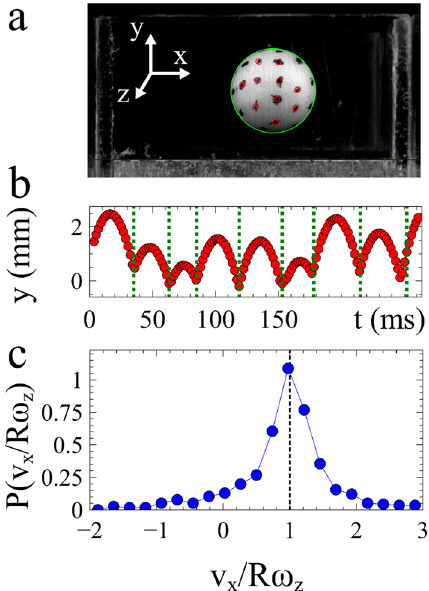
Figure 1. Bouncing ball experiment. ( a ) The position of the surface (blue) and ball (green) are tracked. The rotation of the ball is also measured by tracking the motion of black dots (red) on the ball surface. ( b ) The location of a bounce is identified when d y / d t changes from negative to positive. ( c ) Histogram of v x / R ω z . The rolling condition occurs when v x / R ω z = 1 . (Figure prepared using Veusz https ://veusz .githu